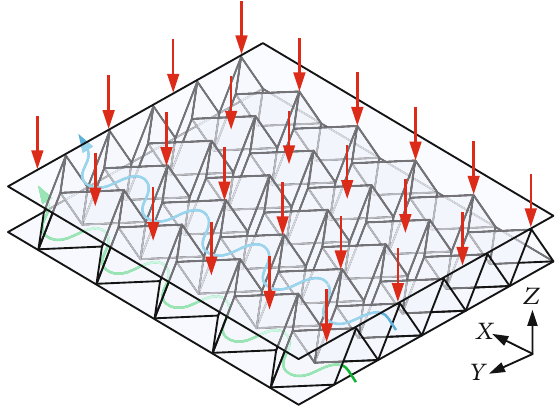
Figure 1: Illustration of a heated V-pattern folded core sandwich structure subjected to forced